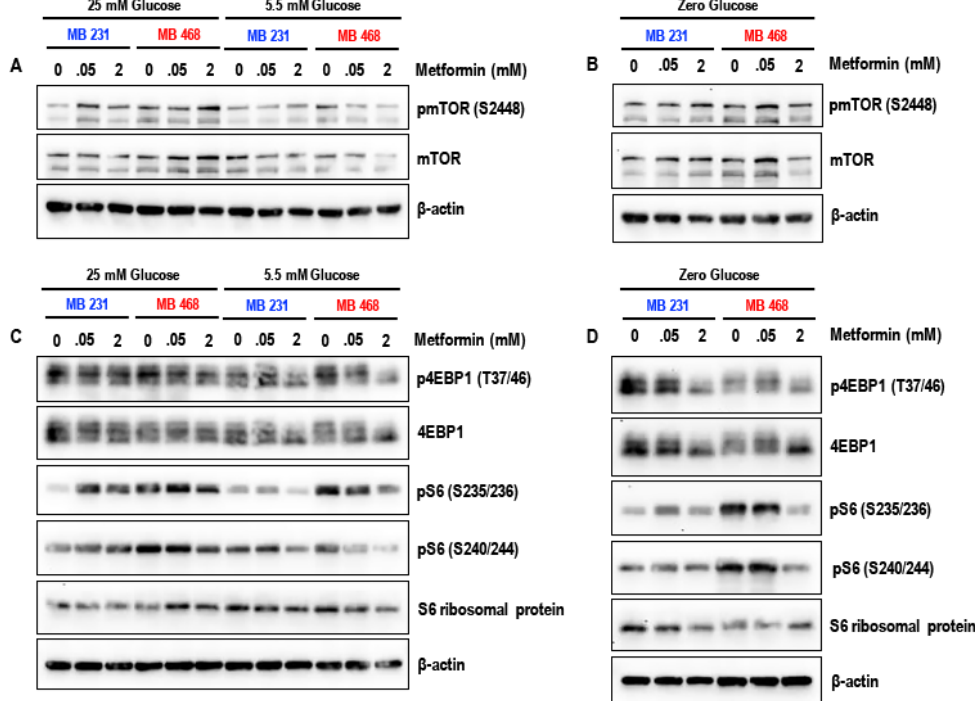
Figure 5. Side-by-side comparison between MDA-MB-231 and MDA-MB-468 cells. Representative western blots ( A ) show the effect of metformin (50 µ M and 2 mM) in 25 mM glucose and 5.5 mM glucose on the levels of pmTOR (S2448) and mTOR in MDA-MB-231 and MDA-MB-468 cells, ( B ) show the effect of metformin (50 µ M and 2 mM) in zero glucose/glucose-starved condition on the levels of pmTOR (S2448) and mTOR in MDA-MB-231 and MDA-MB-468 cells, ( C ) show the effect of metformin (50 µ M and 2 mM) in 25 mM glucose and 5.5 mM glucose on the levels of p4EBP1 (T37/46), 4EBP1, pS6 (S235/236), pS6 (S240/244), and S6 ribosomal protein in MDA-MB-231 and MDA-MB-468 cells, and ( D ) show the effect of metformin (50 µ M and 2 mM) in zero glucose/glucose-starved condition on the levels of p4EBP1 (T37/46), 4EBP1, pS6 (S235/236), pS6 (S240/244), and S6 ribosomal protein in MDA-MB-231 and MDA-MB-468 cells. β -actin was used as the loading control.